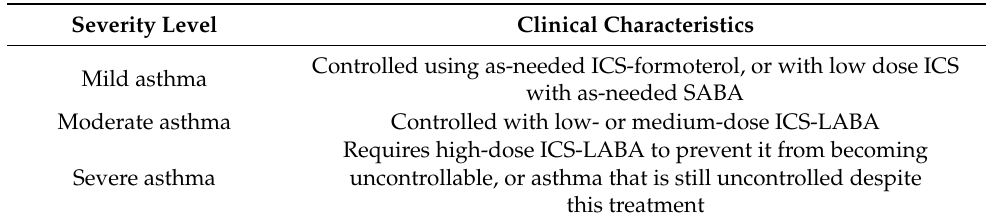
Table 1. The classification of asthma severity according to the 2022 GINA guidelines; Adapted from [14]. Severity